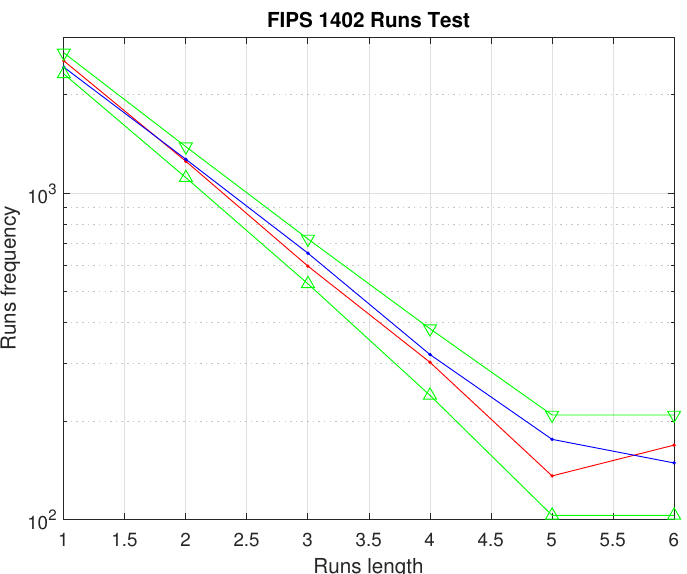
Figure 1. Run test for a 10-interleaving sequence generated from a PN -sequence with characteristic polynomial of degree